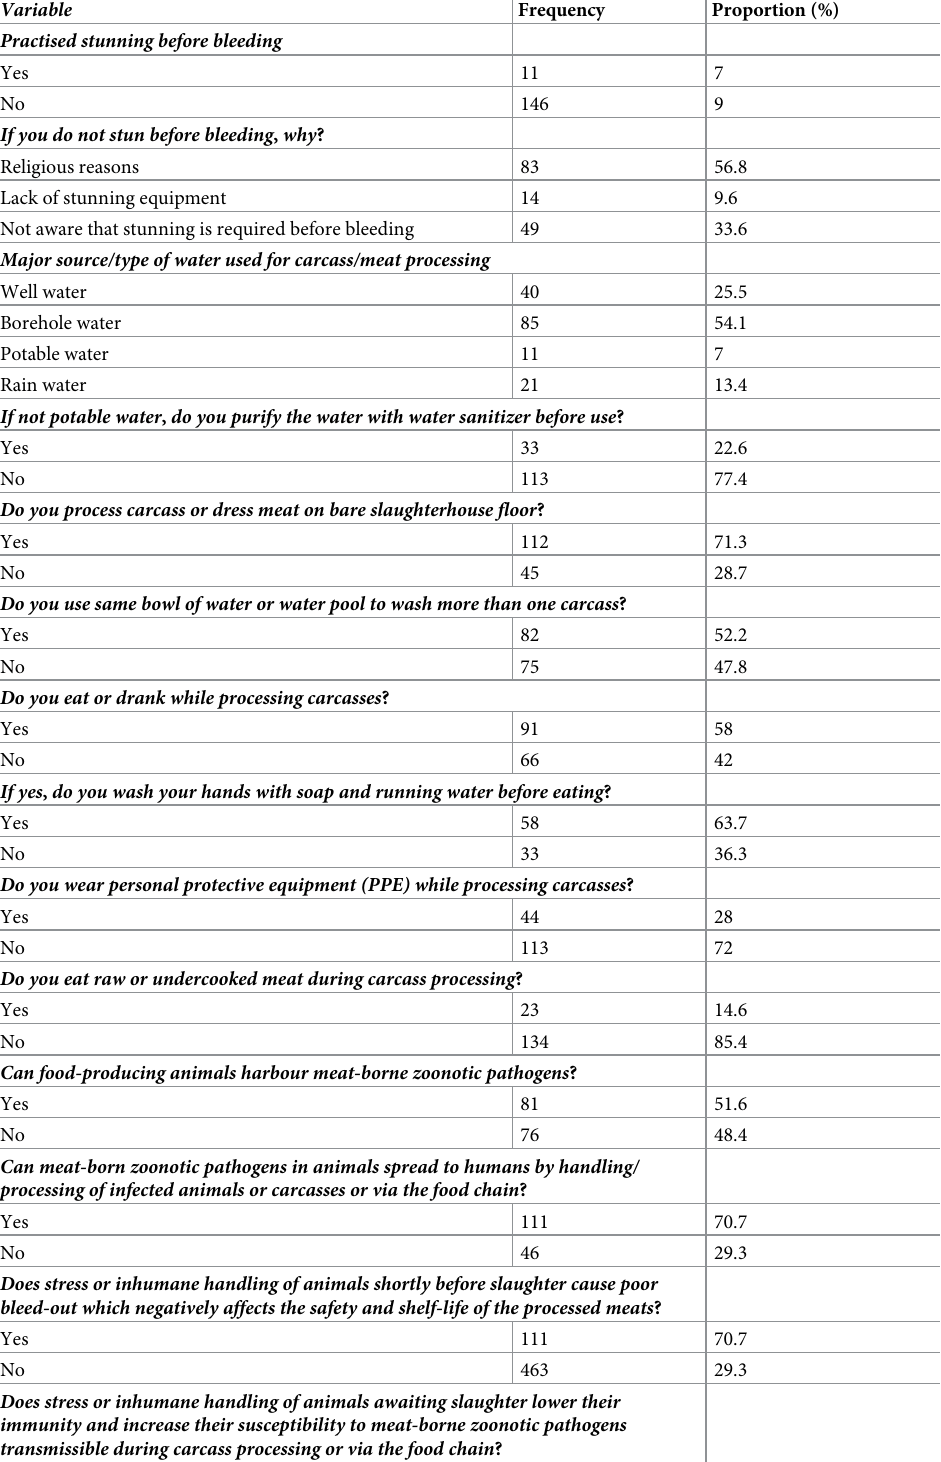
Table 2. Perceptions of slaughterhouse workers (n = 157) on hygienic meat processing and their knowledge of modes of transmission of meat-borne zoonotic pathogen during routine slaughterhouse operations in Southeast,